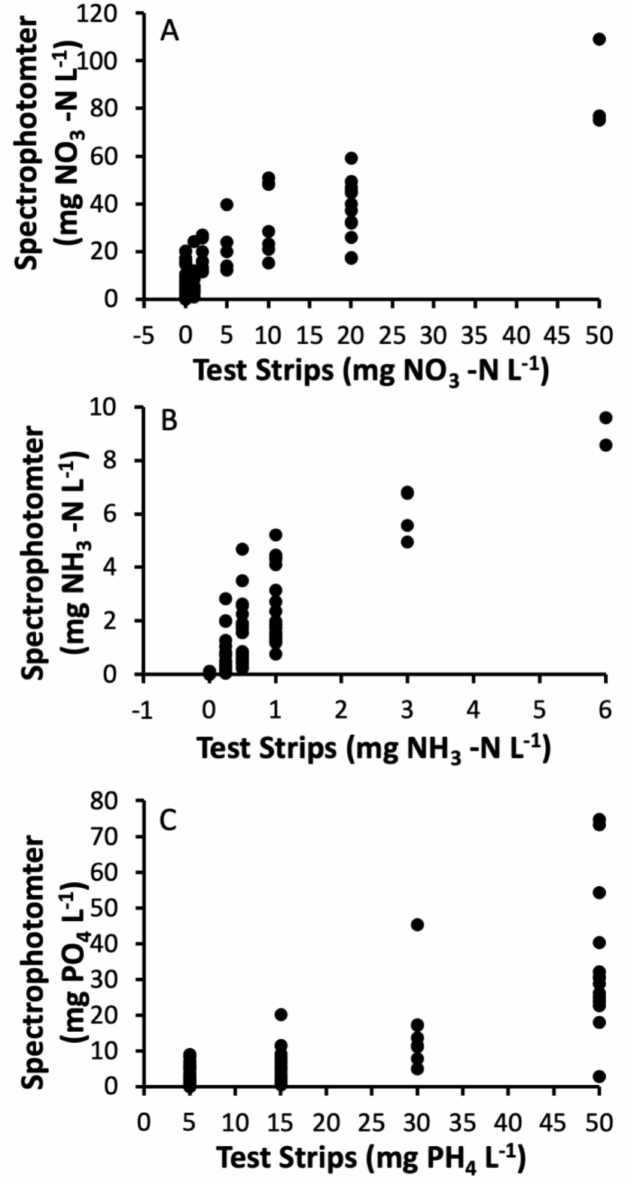
Figure 1. Spectrophotometer versus chemical test strip estimates of dissolved ( A ) nitrate, ( B ) ammo- nia, and ( C ) phosphate in water samples from water-holding